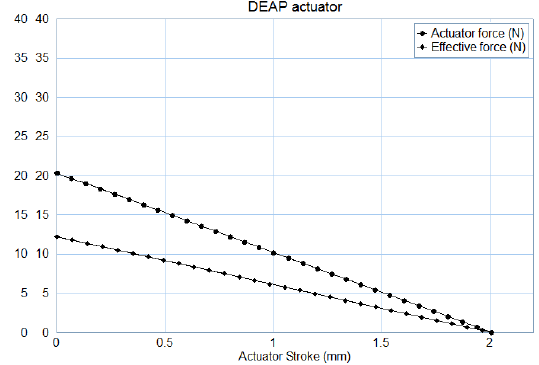
Figure 12: The push actuator Maxwell and Effective Force vs. Effective Stroke